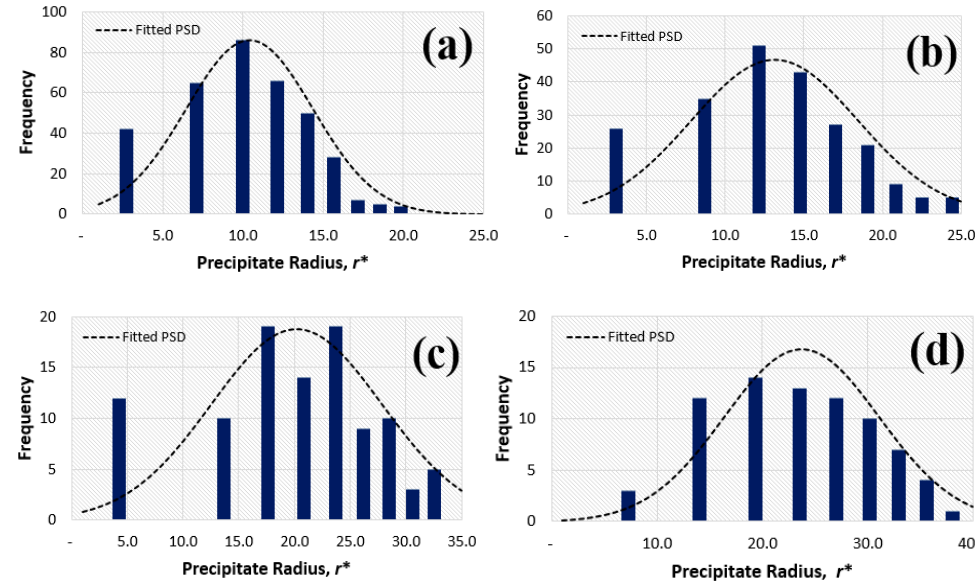
Figure 13. Histograms of the PSD in presence of 30% nanoparticles of size 30 at different times, t *, of: ( a ) 1000, ( b ) 2500, ( c ) 10,000 and ( d ) 20,000.